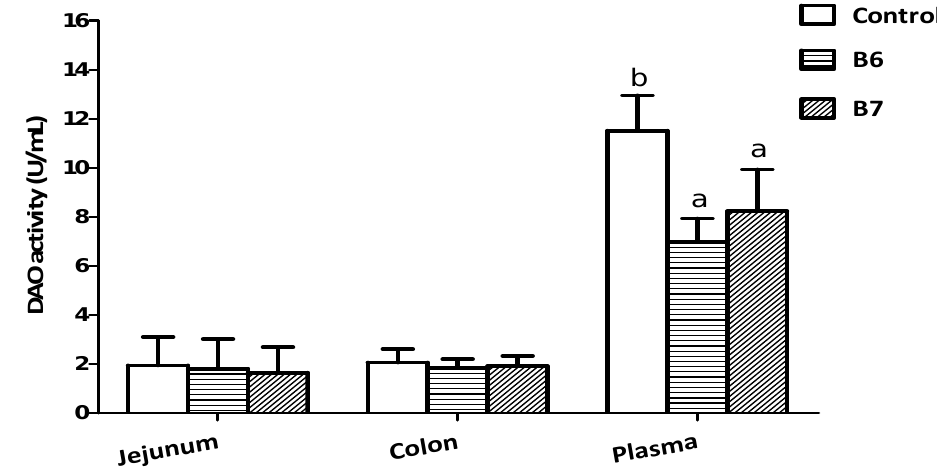
Figure 1. Effects of B. coagulans on diamine oxidase (DAO) activity in the jejunim, colon, and plasma. a,b Values within a row with different letters differ ( p < 0.05).